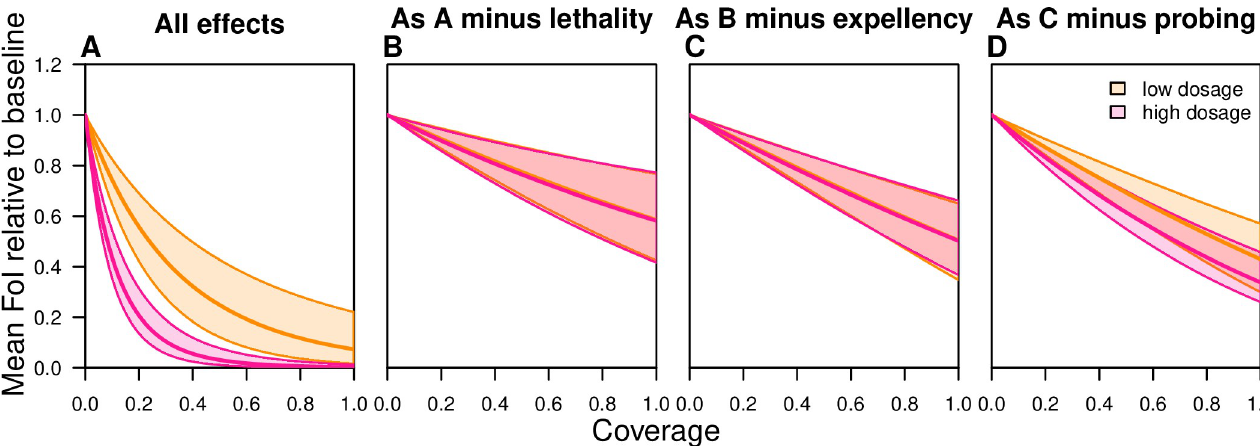
Fig 3. Composite effects of an experimental SR product containing transfluthrin on relative force of infection (FoI) as a function of coverage across houses in a community. (A) all effects, i.e, for this product formulation increased (partial) blood feeding or probing, delayed oviposition or time until fully blood fed, increased acute and delayed mortality, reduced entry rates (repellency), and reduced exit rates (expellency). (B) as A without lethality effects, (C) as B without expellency, and (D) as C without probing effect, with the median default estimates (solid lines) and the 2.5th and 97.5th percentile for the low (orange) and the high (pink) experimental